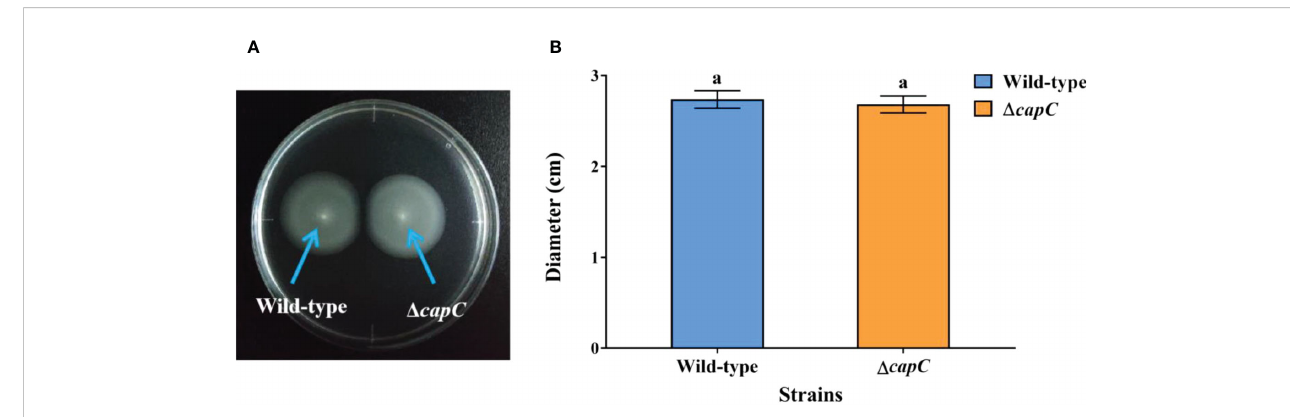
FIGURE 3 The swimming motility of experimental strains. (A) The swimming motility phenotypes of P. marina and D capC strains. (B) The migration zone diameter of P. marina and D capC